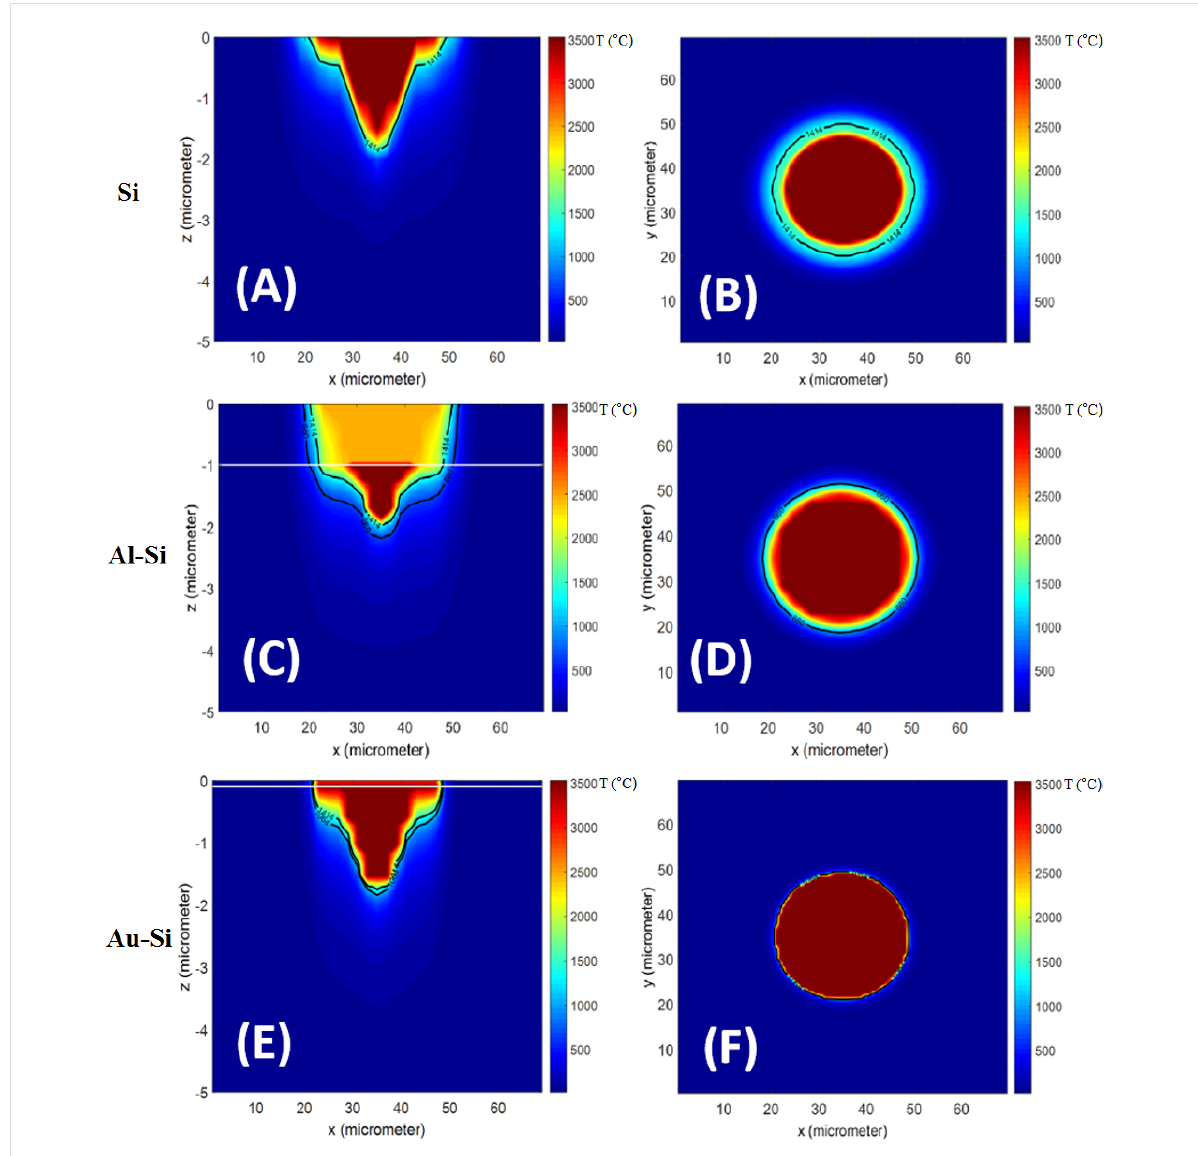
Figure 3: Temperature contours obtained from the numerical model at the end of the pulse at 50 kHz and 5 W for (a) cross-section of uncoated Si, (b) surface of uncoated Si, (c) cross-section of Al coated Si (d) surface of Al coated Si, (e) cross-section of Au coated Si, (f) surface of Au coated Si. The melting points of the materials are depicted by black lines and the interface between the layers is shown by white